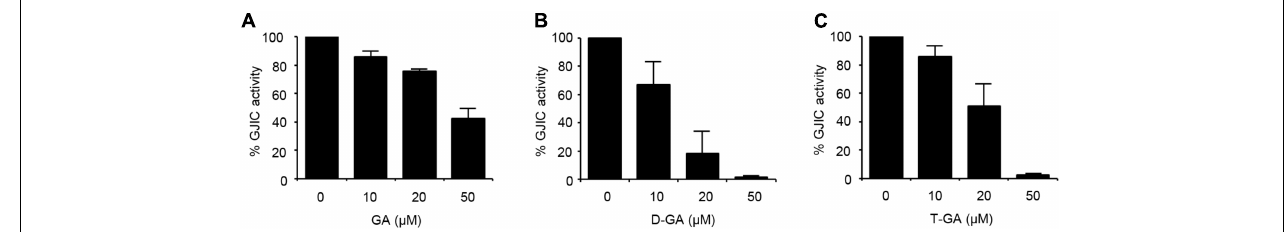
FIGURE 2 | Inhibition of GJIC by GA, D-GA, and T-GA. I-YFP GJIC assay (see Materials and Methods) was conducted using LN215-I and LN215-YFP cells. The vehicle, GA (A) , D-GA (B) , or T-GA (C) was diluted in C-solution and applied to cells at the concentrations indicated above for 10 min before the GJIC assay. The mean % of GJIC activity ± SD of three independent experiments is presented as bar graphs.